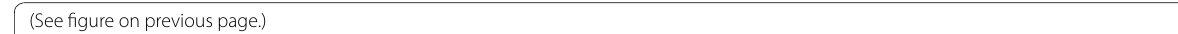
figure on previous Fig. 4 Ammonites from the Urgonien Jaune (UJ) of the Vaud Jura Mountains. 1 – 2 : Cruasiceras cf. cruasense (Torcapel 1884), reworked, original negative imprint (1) and positive plaster mould (2) of an adult whorl portion, Eclépens quarry, basal UJ, early Late Hauterivian (Sayni Zone), MGL 101510. 3 – 5 : Lyticoceras claveli (Busnardo and Thieuloy 1989), reworked fragment in opposite lateral views (3–4) and ventral view (5), Eclépens quarry, basal UJ, late Early Hauterivian (Nodosoplicatum Zone), MGL 97797. 6 – 18 : Pseudometahoplites sp. juv., internal mould of a nucleus, Montcherand section (Gorges de l’Orbe), basal Marnes de la Russille, Mid‑Barremian Compressissima/Moutonianum to Vandenheckii Zones, MGL 101512, imagery by CLSM “confocal laser scanning microscopy” (6–14), optical microscopy (15–16) and SEM “scanning electron microscopy” (17–18) with lateral views (opposite sides: 6, 7–8, 15, 17), ventral views (11, 13–14, 16, 18) and variable views by 3D image rotation (9–13), ornamentation schemes (8, 14) with tubercles and ribs marked in red for primary ribs or in white for secondary